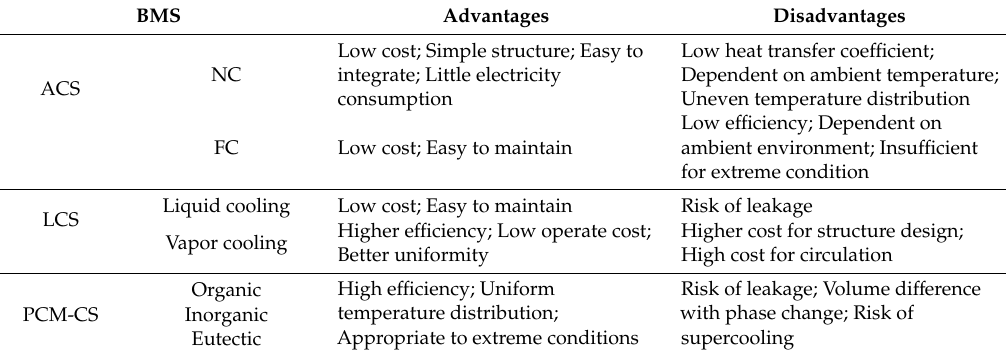
Table 4. Comparison among di ff erent kinds of battery management